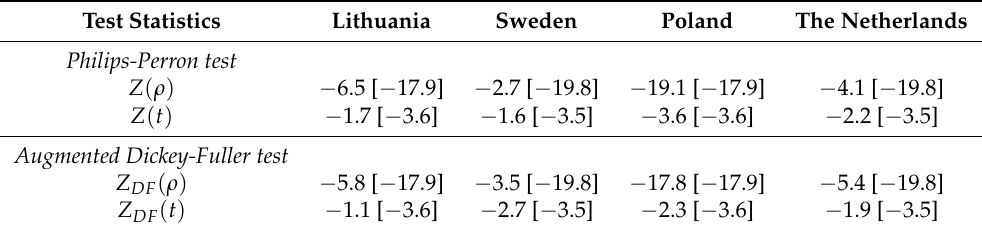
Table 3. Statistical testing for unit-roots for the time series parameter of κ ( t )